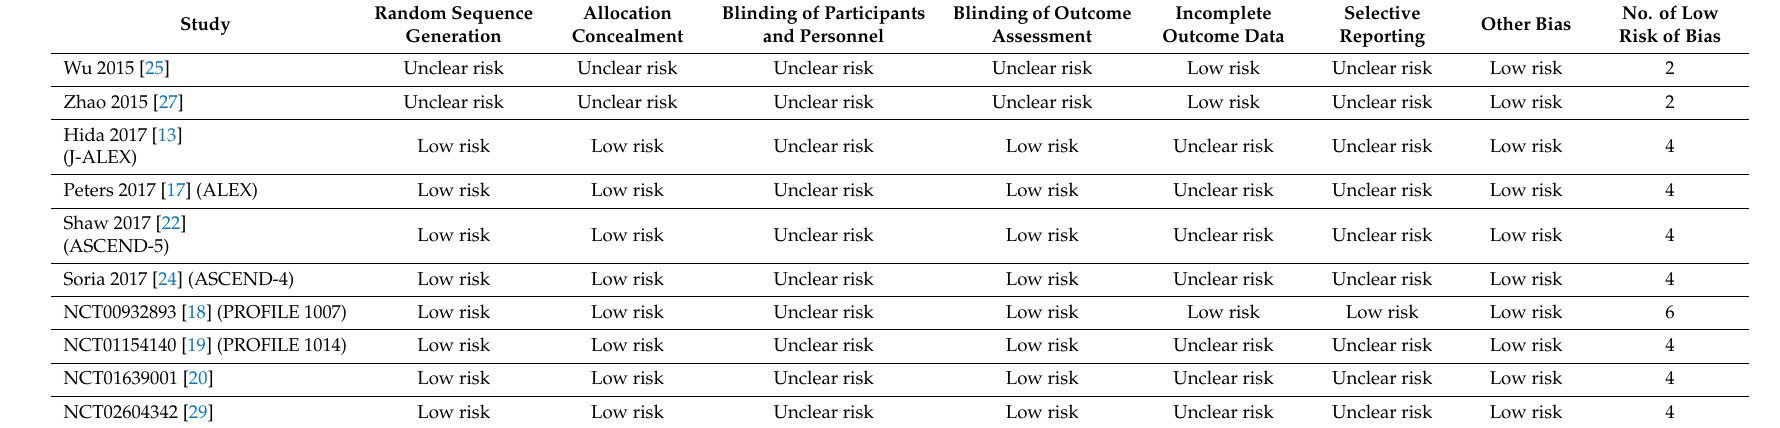
Table 2. Summary of risk of bias assessment for randomized, double-blind, placebo-controlled trials ( n =